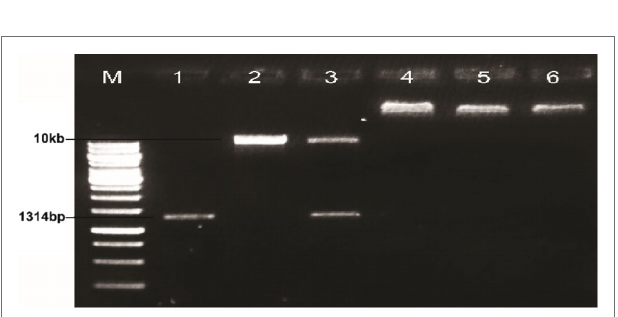
FIGURE 2 | Analysis of sequencing results showing different SNPs and Indel in MBI7747 ( Gh_A07G1537 ) as compared with its parents of CCRI45 and Hai1; (A) detection of Indel of 55 bp and (B) detection of SNPs.